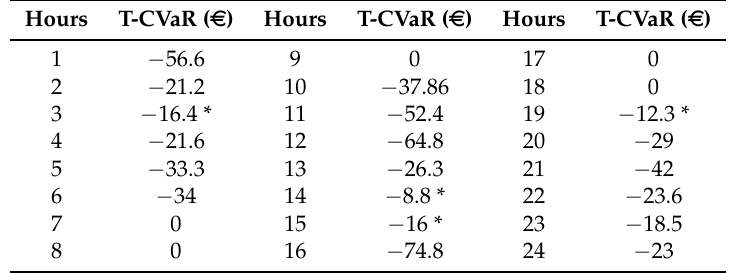
Table 5. The hourly hourly conditional value at risk (T-CVaR) values; χ =